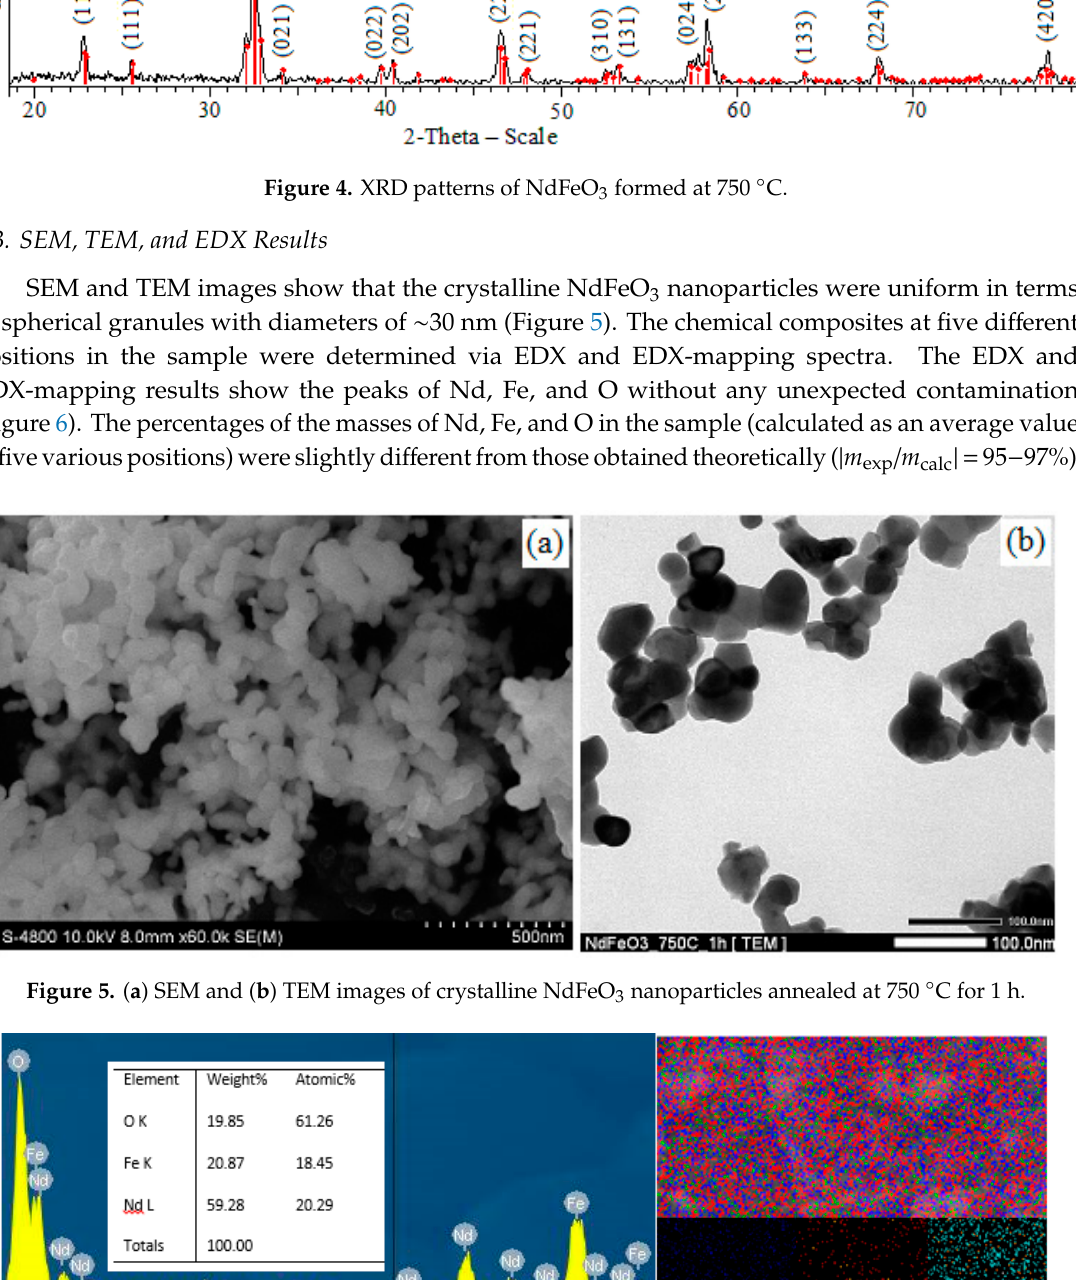
Figure 4. XRD patterns of NdFeO 3 formed at 750 °C. Table 1. Lattice parameters and magnetic properties of crystalline NdFeO 3 particles annealed at 750 °C.